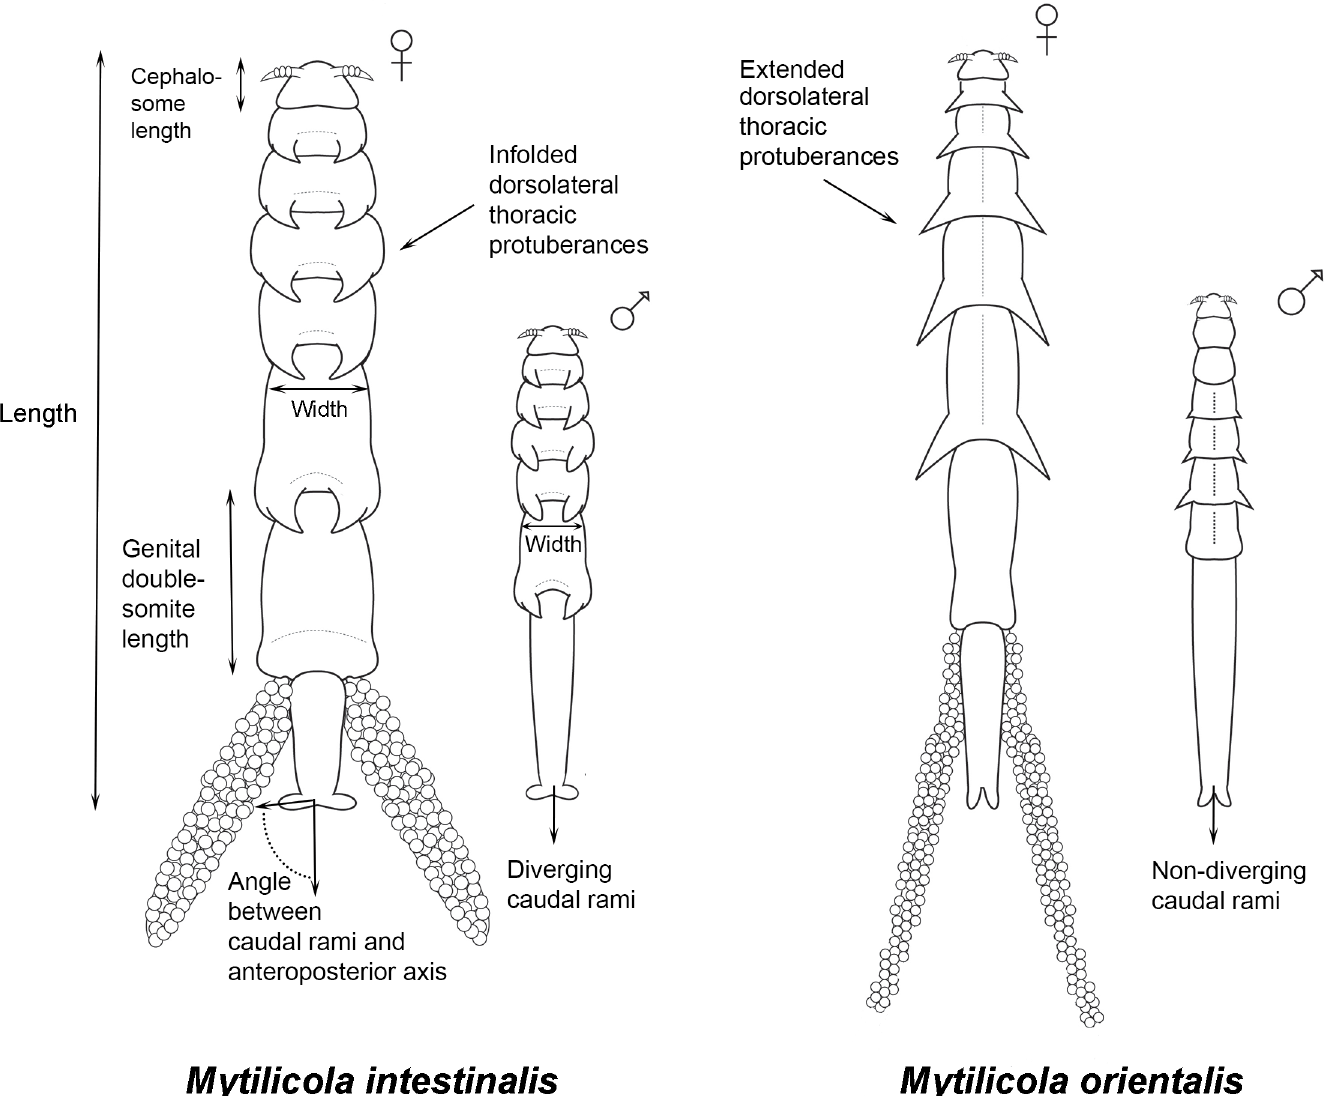
Fig 2. Schematic representation (not to scale) of both sexes of both introduced Mytilicola species. On the left both sexes of M . intestinalis and on the right both sexes of M . orientalis , all viewed from the ventral side, with indications of the body size measurements that were taken. Note the dorsolateral thoracic protuberances which are folded inwards in M . intestinalis and extended outwards in M . orientalis . For detailed drawings see original species descriptions, including views from other sides and close-ups [15, 23]. Drawings with courtesy of Felipe Ribas.